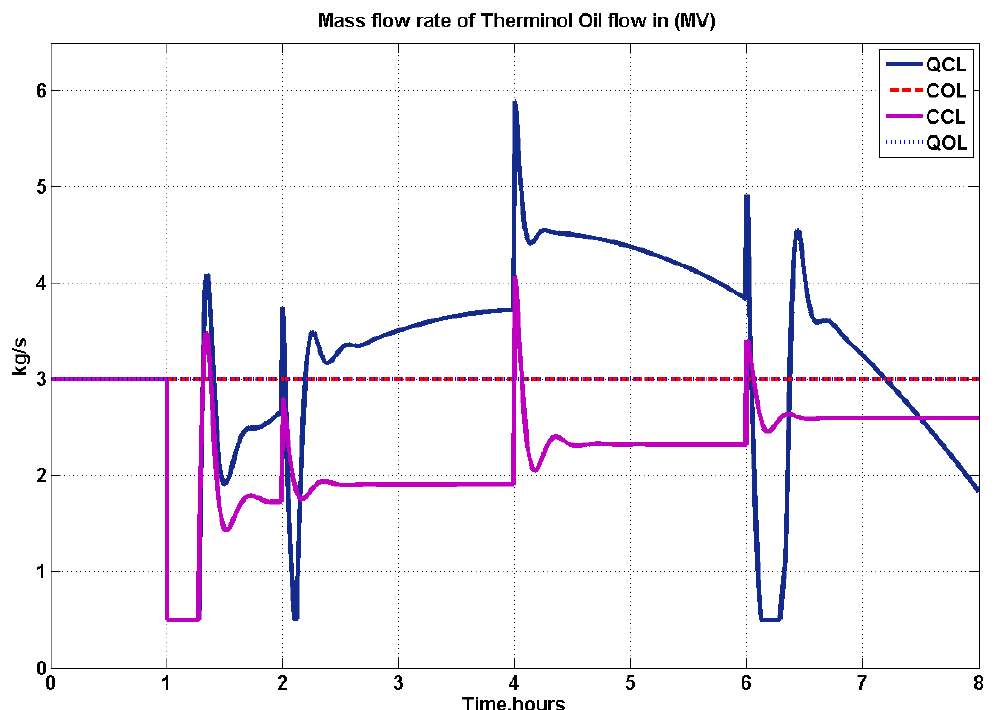
Figure 13. Manipulated variables (MV) of therminol oil.